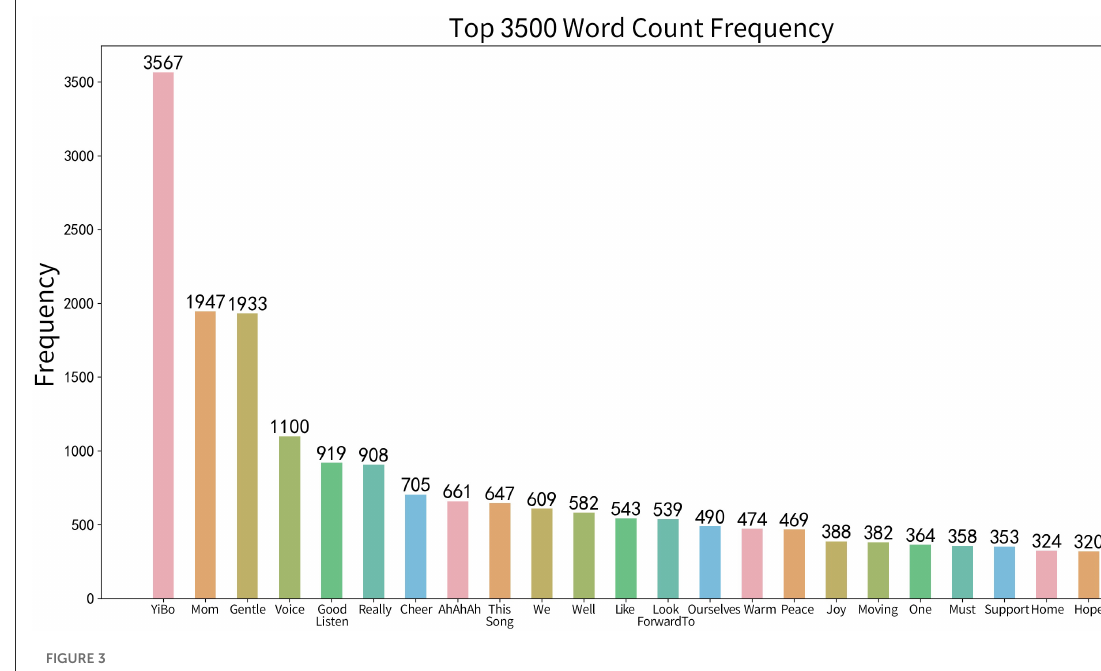
FIGURE3 Top 3,500 frequently recurring words.